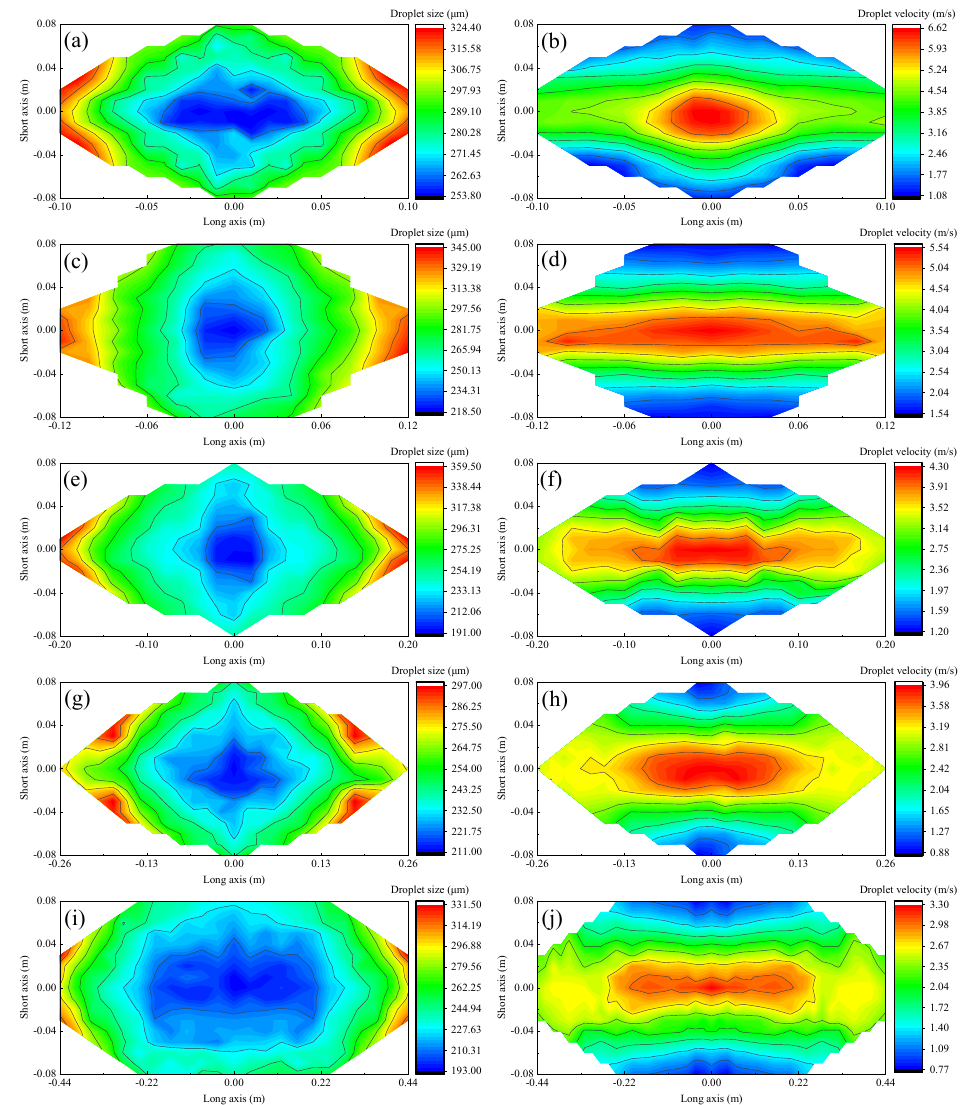
Figure 4. Cloud chart of droplet size and velocity for five flat fan nozzles at 0.25 MPa and 0.50 m away from the nozzle outlet: ( a , b ) 2504; ( c , d ) 4004; ( e , f ) 6504; ( g , h ) 8004; and ( i , j ) 11004.